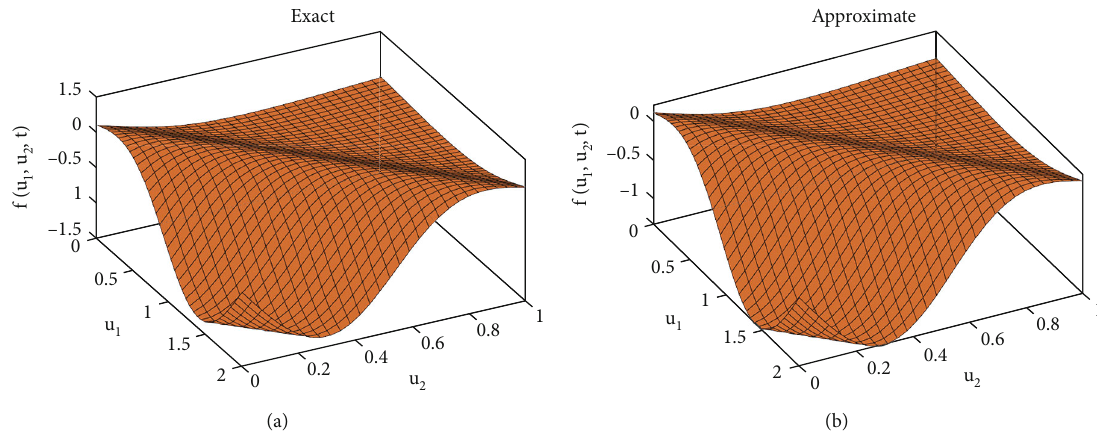
: u t Þ when δ 1 , 2 , 1 = 1